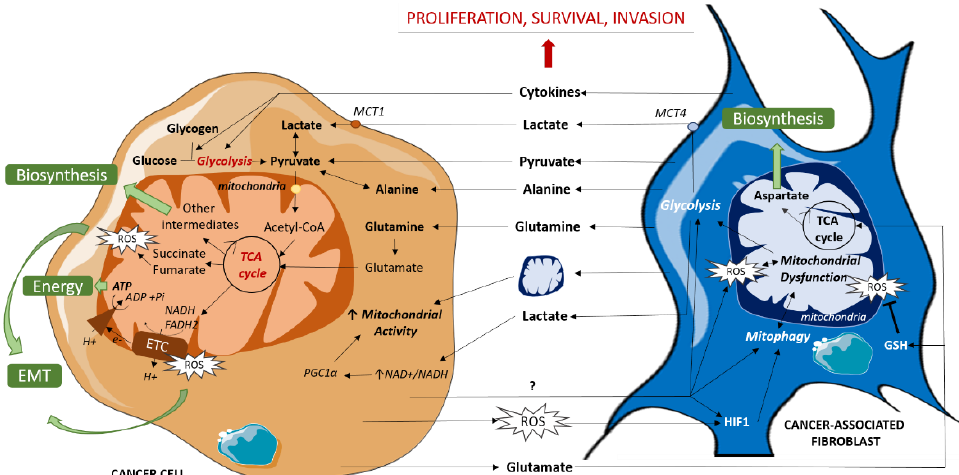
Figure 1. Metabolic dialogue between cancer cells and CAFs. CAFs fuel TCA cycle by directly providing cancer cells with organic (lactate, pyruvate) and amino acids (alanine, glutamine) or indirectly by enhancing glycolysis via cytokine release, resulting in an increase in mitochondrial activity which leads to energy and biosynthetic precursor production and redox state modulation. CAFs also enhance mitochondrial activity via mitochondrial transfers. In turn, cancer cells induce mitochondrial dysfunction in CAFs, mitophagy and ROS production, amplifying their mutual